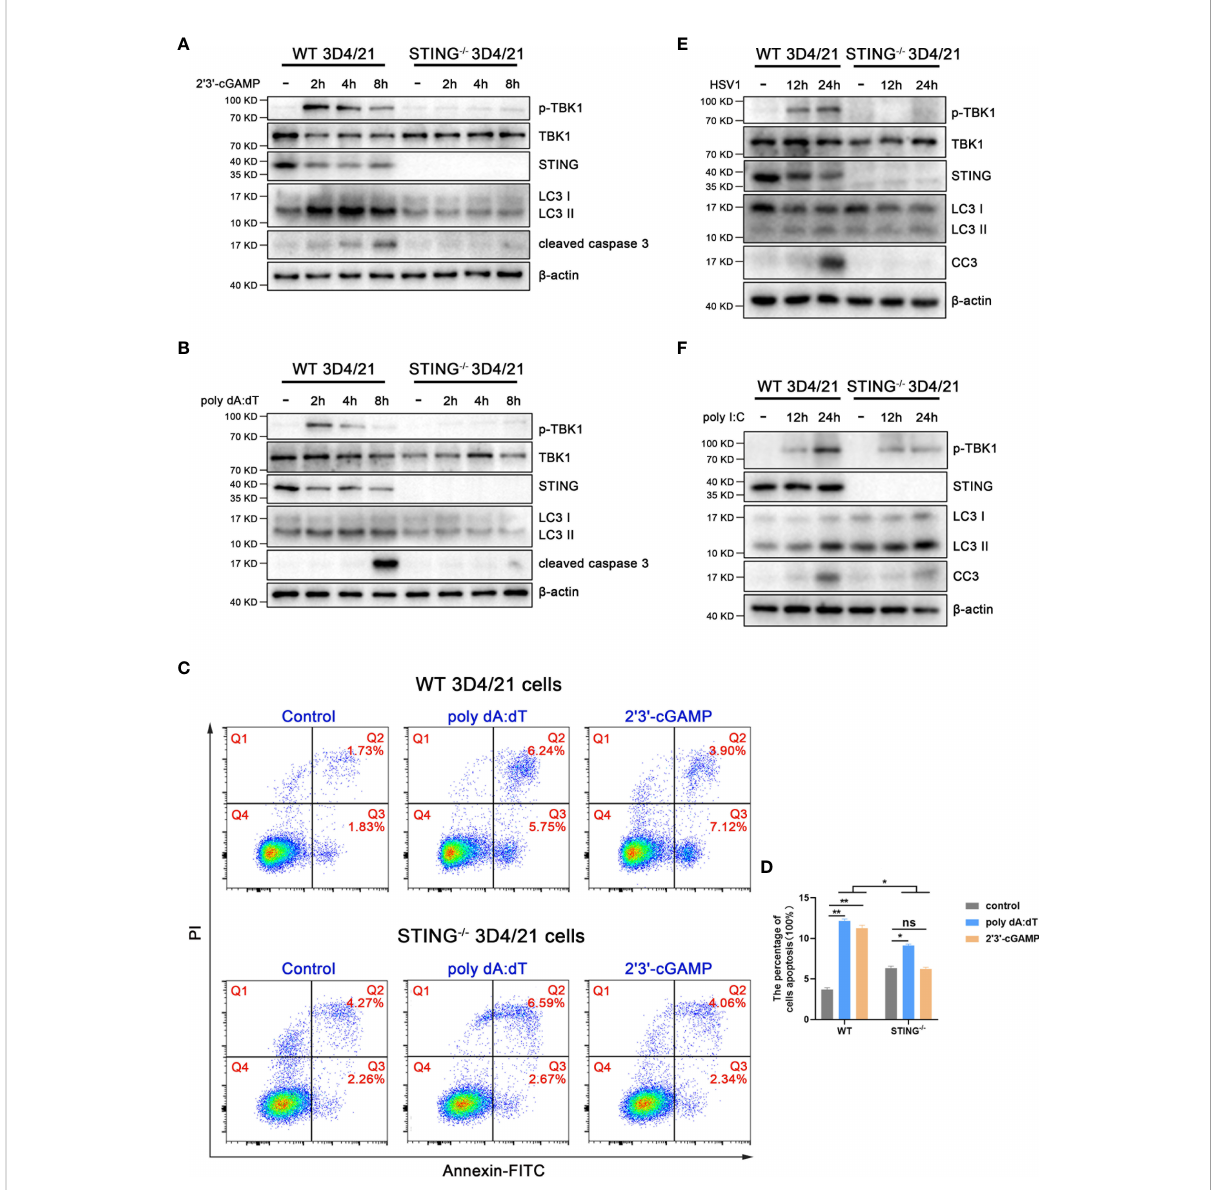
FIGURE 3 STING is essential for autophagy and apoptosis. STING -/- and wild type 3D4/21 cells were stimulated by 2 ’ 3 ’ -cGAMP (1 m g/mL) (A) , poly dA:dT (1 m g/mL) (B) , HSV1 (MOI=0.01) (E) or poly I:C (1 m g/mL) (F) , respectively. Cells were harvested at the indicated times and analyzed by Western blotting. The abbreviations CC3 in (E) , (F) and subsequent Figures all denote cleaved caspase 3. (C, D) Cells were stimulated with 2 ’ 3 ’ -cGAMP or poly dA:dT for 16 h, and the stimulated cells were stained with annexin V and PI followed by fl ow cytometry for cell apoptosis analysis. ns, not signi fi cant; * p < 0.05 and ** p <